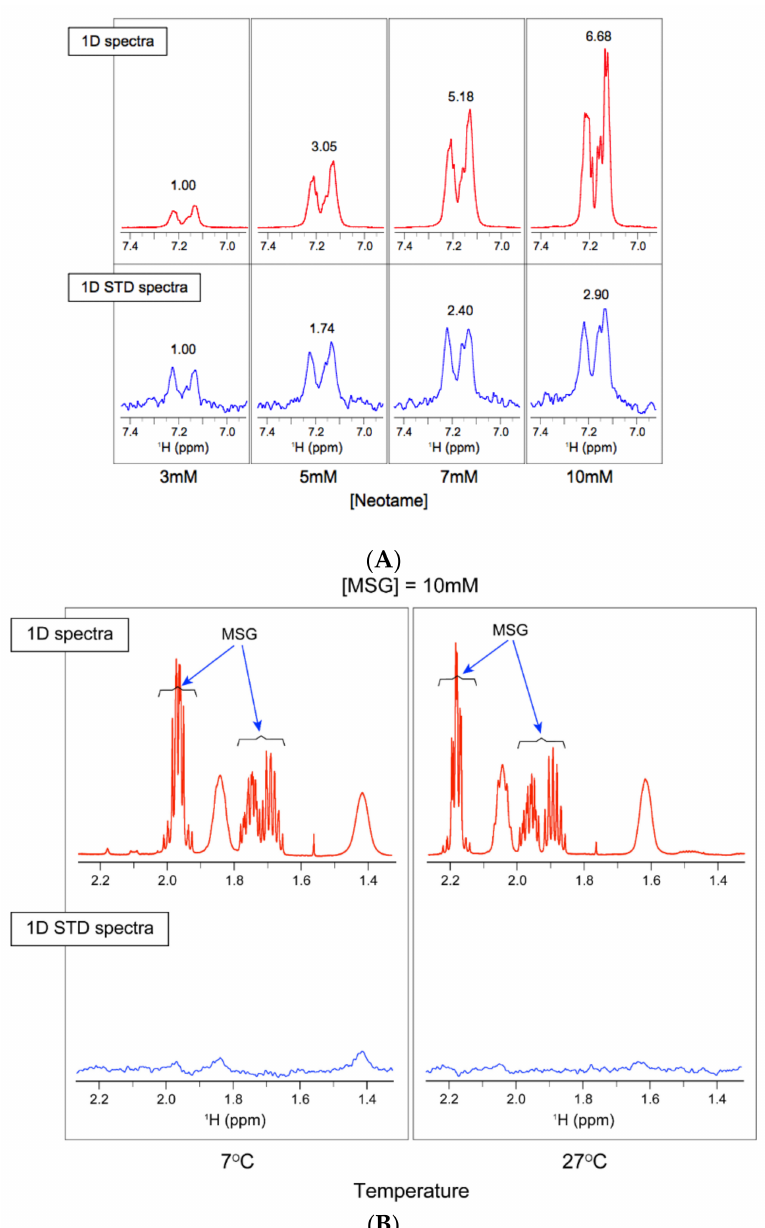
Figure 4. Saturation transfer difference spectra of His tagged human T1R2 ATD. NMR data were collected on a Varian VNMRS spectrometer operating at 800 MHz and equipped with a cryogenic probe. ( A ) Human T1R2 ATD ± neotame at 27 ◦ C. Top panel shows one-dimensional (1D) 1 H-NMR, and the bottom panel shows 1D STD NMR spectra of neotame at increasing concentrations (3–10 mM). The observed STD signals increase with the concentration of neotame, indicating that neotame binds to the receptor domain; ( B ) human T1R2 ATD ± MSG (negative control) measured at 7 and 27 ◦ C. Top panel shows 1D 1 H-NMR with MSG proton signals, and bottom panel shows STD spectra. Lack of STD signal in MSG spectra indicates no